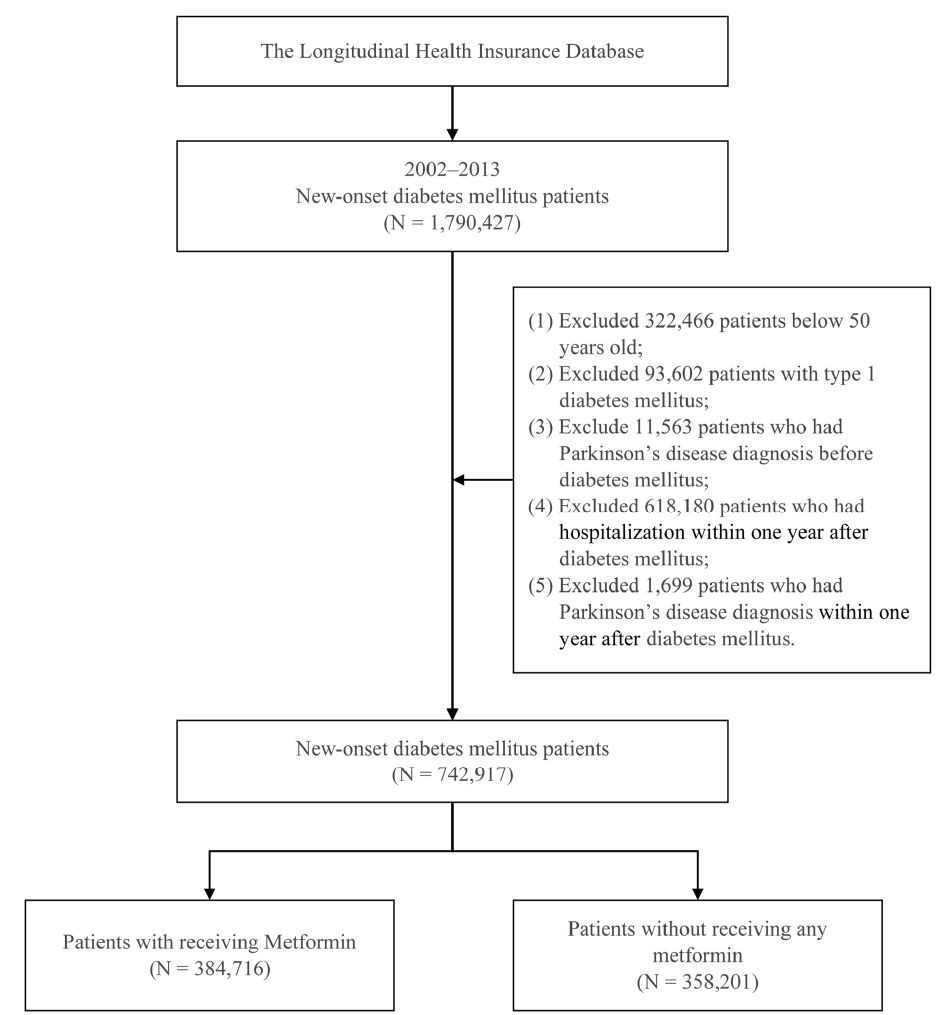
Figure 1. Patient selection process.